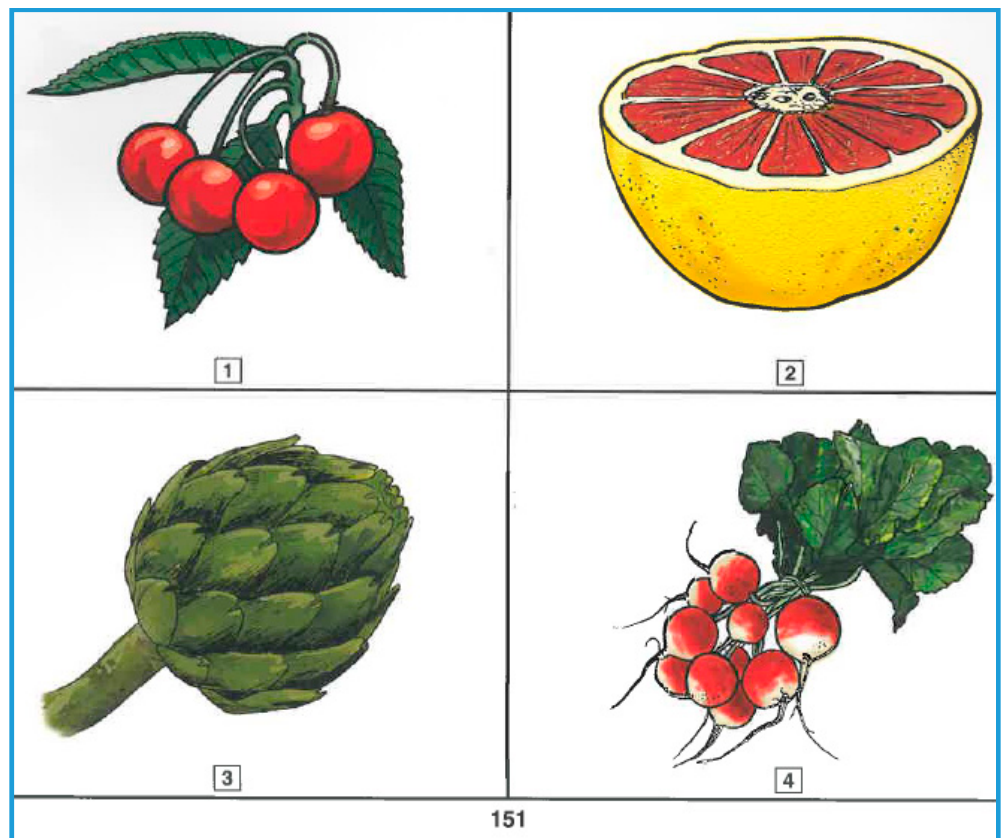
Figure 1. Item sample from the Peabody Picture Vocabulary Test (PPVT) ( citrus ).